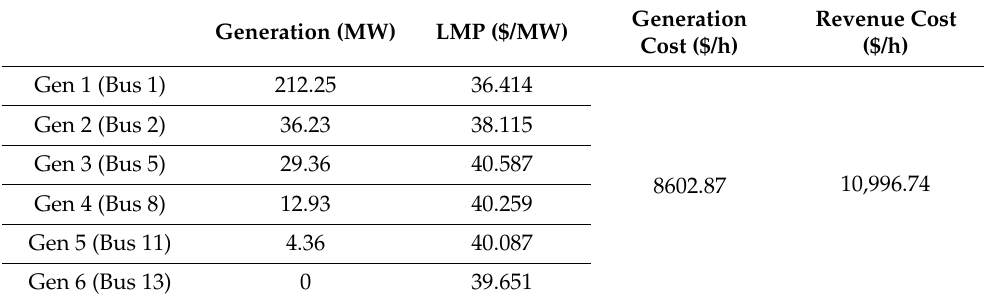
Table 3. Revenue and generating costs with a single auction bidding system without WF.